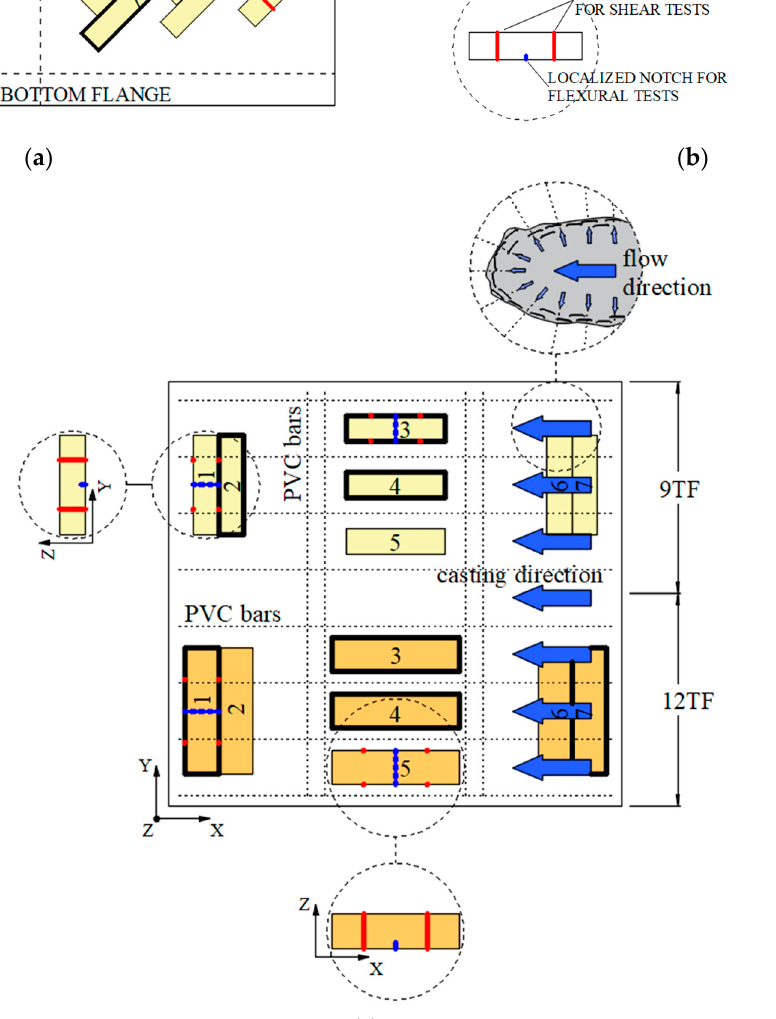
Figure 2. Identification of extracted prisms from: ( a ) mock-up’s web’s Side 1; ( b ) web’s Side 2 and ( c ) top flanges. ( c ) top